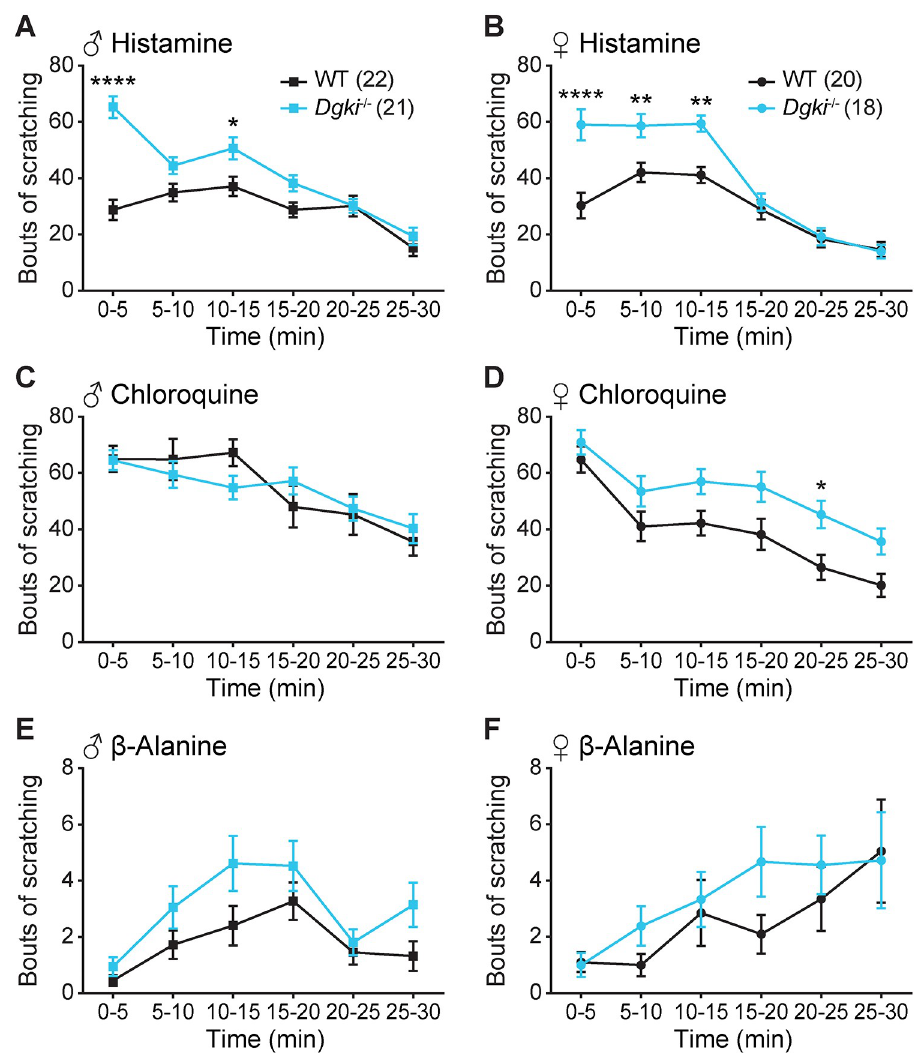
Fig 2. Loss of Dgki enhances histamine-induced scratching in male and female mice. An acute scratching assay was used to test itch responses in Dgki -/- mice following an injection of 500 μ g histamine (A-B), 200 μ g chloroquine (C-D), or 500 μ g β -alanine (E-F) in WT and Dgki -/- male (A,C,E) and female (B,D,F) mice in 5 minute intervals. The number of mice of each sex tested for all pruritogens is indicated in parentheses in (A) and (B). Graphs show mean ± SEM. p < � 0.05, �� 0.01, ��� 0.001, ����